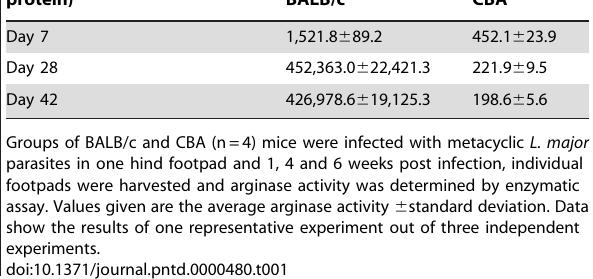
Table 1. Infection with metacyclic L. major parasites results in significantly higher arginase activity in the lesions of BALB/c mice than CBA mice.